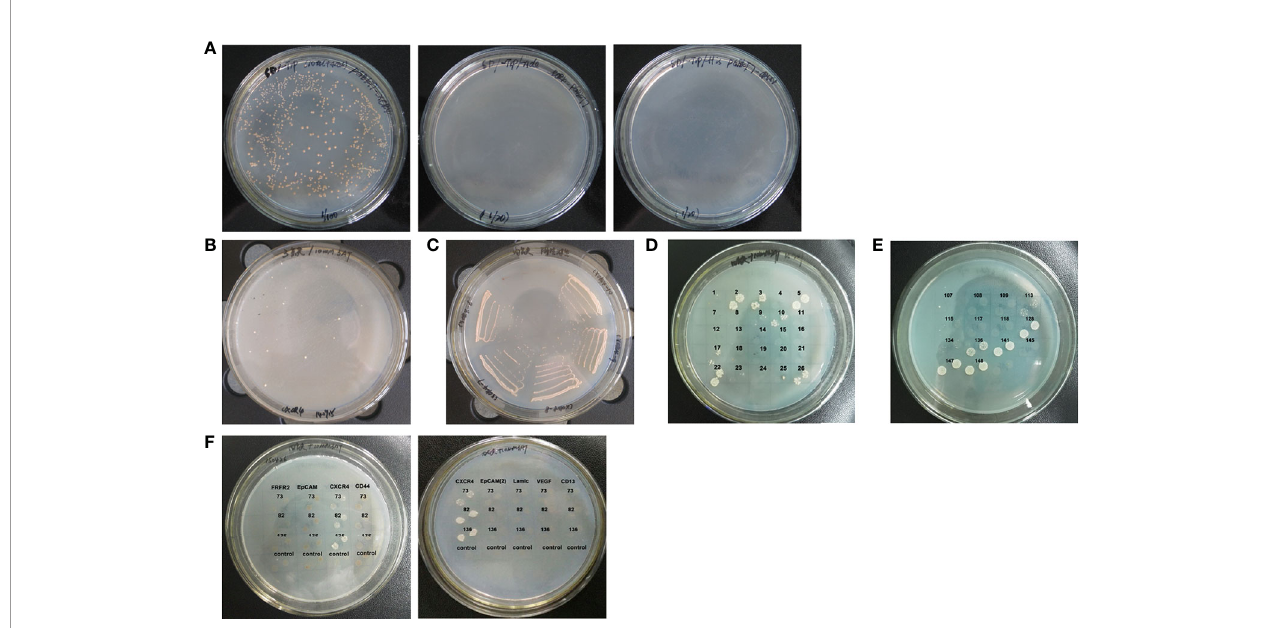
FIGURE 1 | Cloning anti-CXCR4 scFvs from human scFv antibody library. (A) Yeast strain AH109 competent cells were transformed with the bait plasmid pGBKT7- CXCR4 and cultured on the different plates. The clones grew on SD/-Trp plate (Left), but not on SD/-Trp/-Ade plate (Middle) and SD/-Trp/-His plate (Right). These results showed that the bait plasmid alone did not activate the expression of the reporter genes. (B) A total of 241 candidate positive scFv clones were obtained from screening the scFv library. The image shows some representative clones of the 241 candidate positive clones which grew on SD/-Trp/-Leu/-His plates containing 10 mM 3-AT. (C) The image shows some representative clones of the 241 candidate positive scFv clones which were re-streaked on SD/-Trp/-Leu/-His/- Ade plates containing 10 mM 3-AT, so that the clones which grew on the plate were the candidate positive scFv clones, and the false positive clones did not grow. A total of 221 candidate positive scFv clones were identi fi ed. (D) The image shows some representative clones of the 221 candidate positive scFv clones from which the plasmid DNA was isolated and transformed into AH109 containing empty vector pGBKT7. The clones which grew on SD/-Trp/-Leu/-His/-Ade plates containing 10 mM 3-AT were false positive clones, and the candidate positive clones did not grow. A total of 85 candidate positive scFv clones were obtained. (E) The image shows some representative clones of the 85 candidate positive scFv clones from which the plasmid DNA was isolated and transformed into AH109 containing bait plasmid pGBKT7-CXCR4, which were cultured on the SD/-Trp/-Leu/-His/-Ade plates containing 10 mM 3-AT. A total of 14 candidate positive scFv clones were obtained. (F) The images show some representative clones of the 14 positive clones from which the plasmid DNA was isolated and transformed into AH109 containing bait plasmid pGBKT7-CXCR4 or the unrelated antigens as negative controls. Three positive clones contained scFvs which could interact with CXCR4, but, not with the unrelated